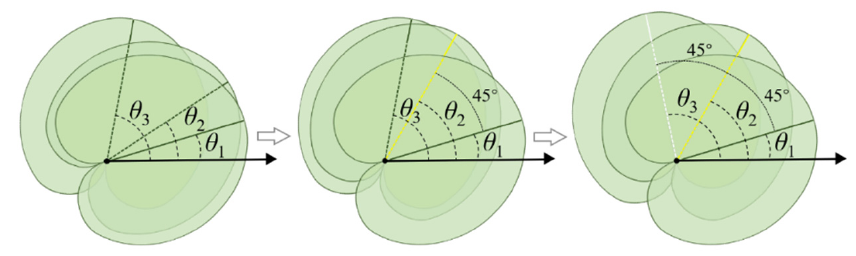
Figure 9. Illustration of extreme case correction.